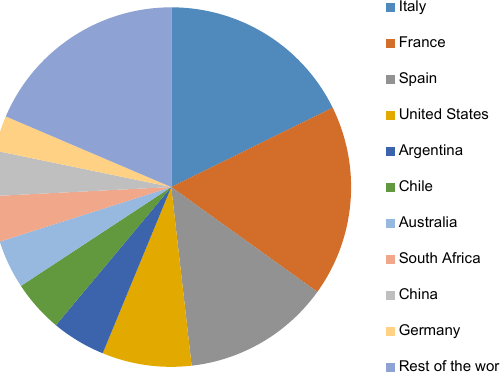
Figure 1. World wine production (2015).